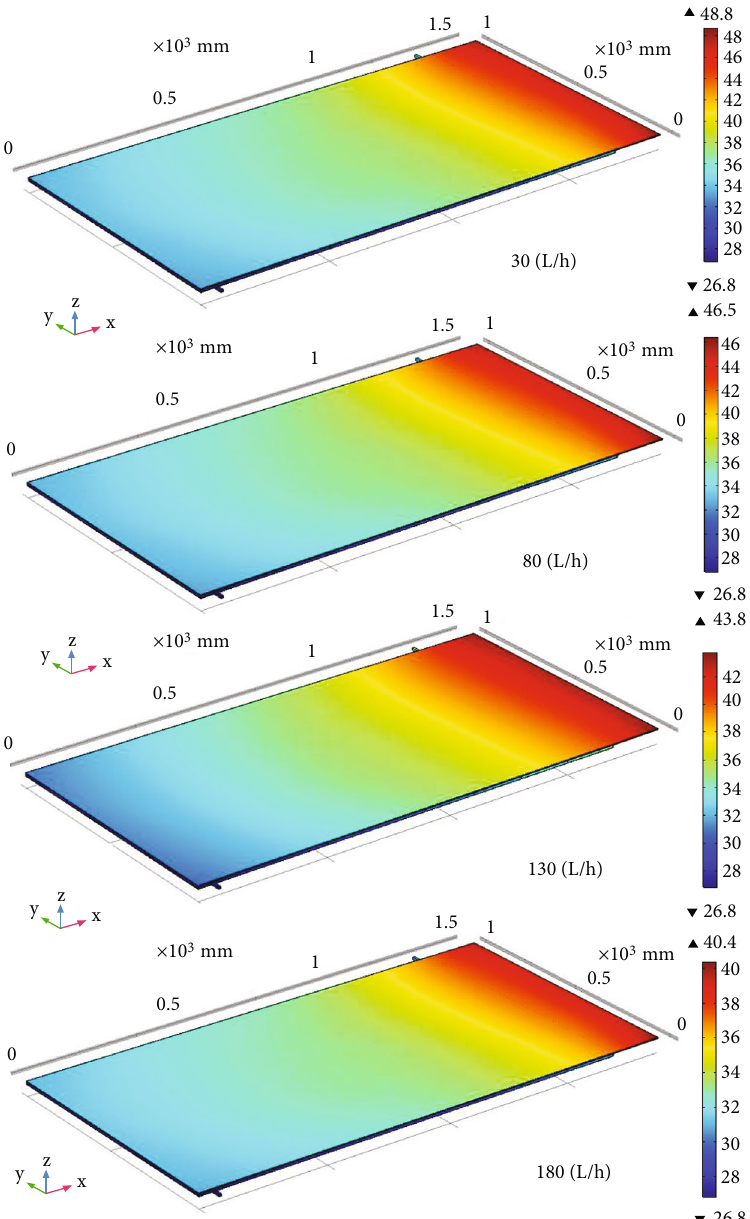
Figure 6: Outcome of mass fl ow rate on PVT surface temperature with G = 500 W/m 2 , T